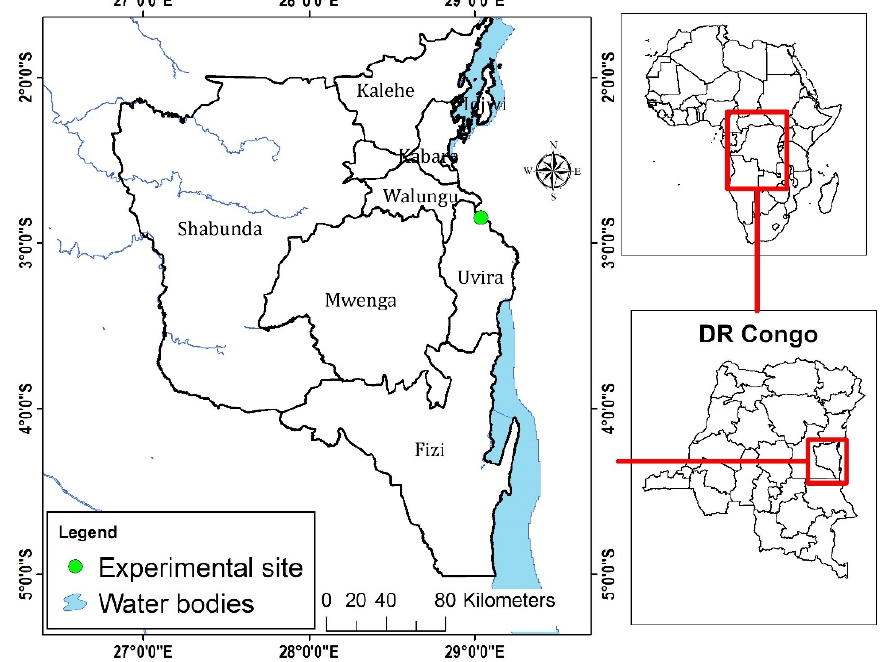
Figure 1. Location of the experimental site, Ruzizi Plain, eastern DRC.